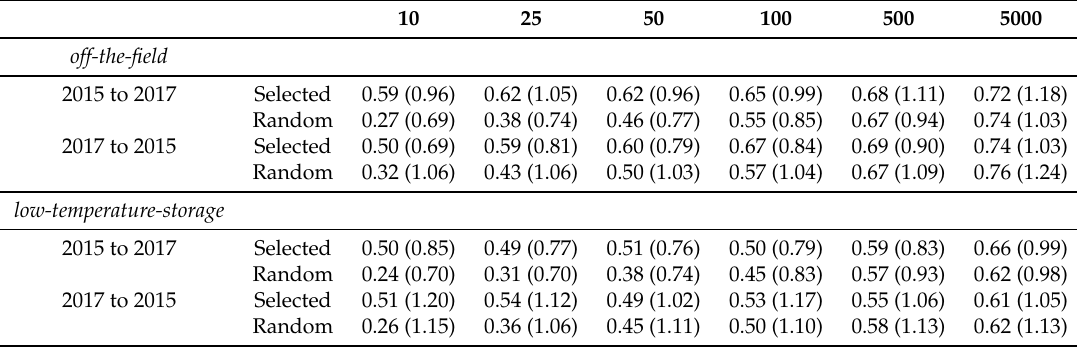
Table 5. Predictive ability for fry color ‘off-the-field’ and after long-term storage at 4.5 ◦ C using selected or random markers (bias is shown in brackets). Selected markers were identified in the training population (either 2015 or 2017) using variable importance measures in Random Forest. In the case of randomly selected SNPs the predictive ability is the mean of 100 iterations of random SNP